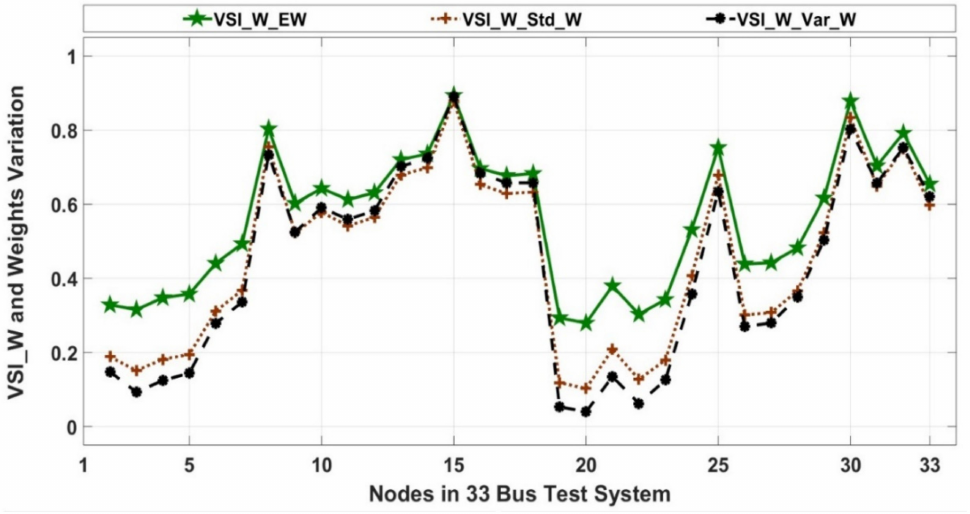
Figure 7. Weighted VSI_W with equally biased weights for the 33-bus MDN. The weights in VSI_W were also allocated on the basis of biased weight variations in terms of standard deviation and variance trends to find the sensitivity analysis of